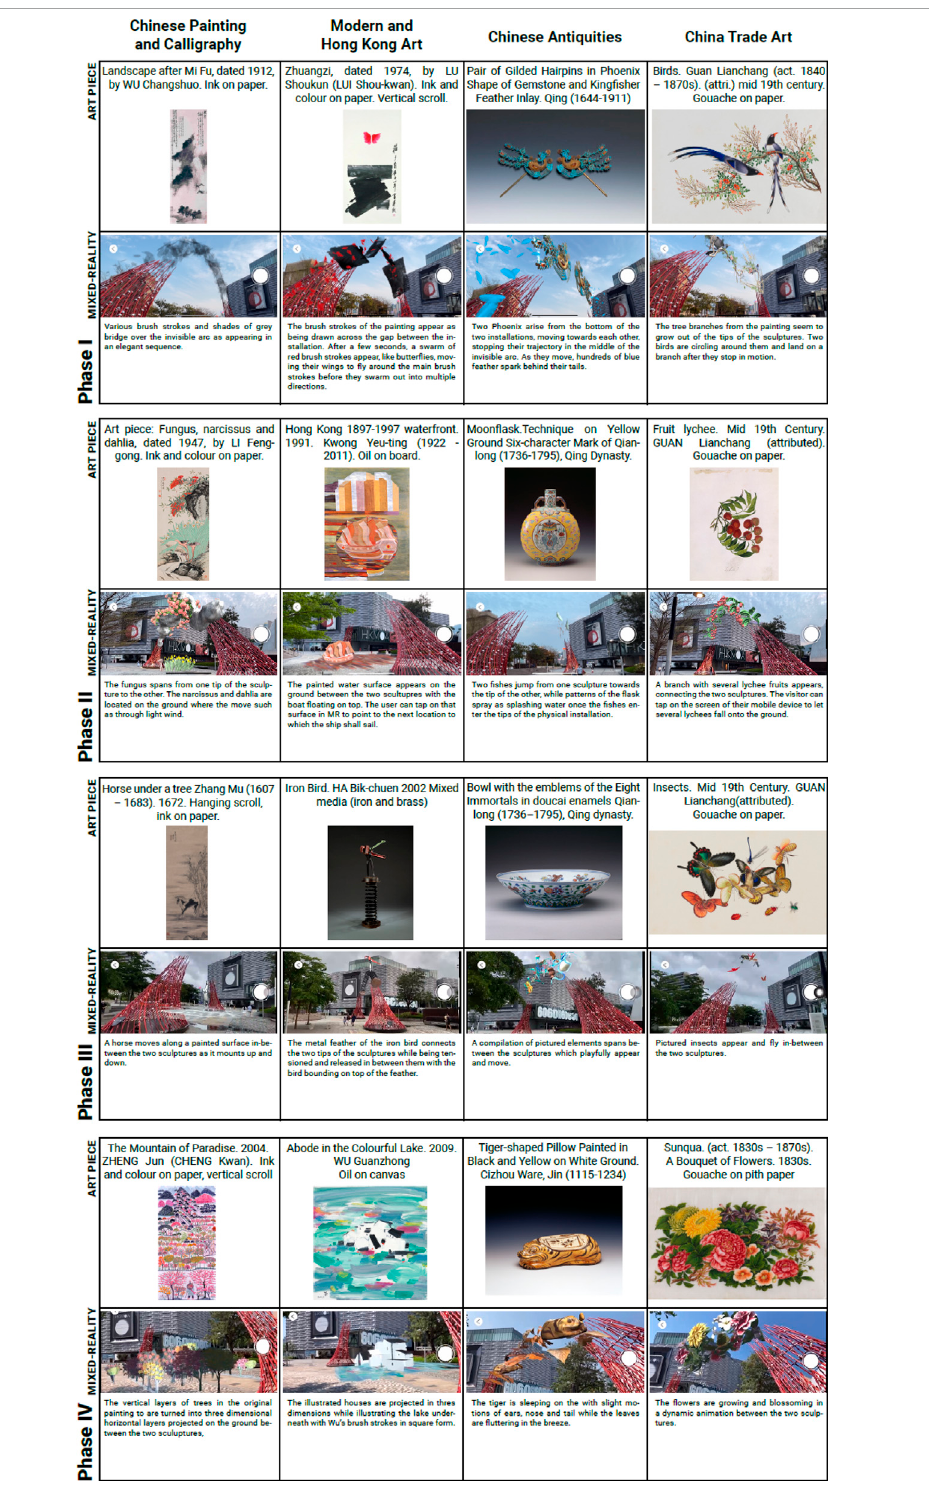
TABLE 1 Assets overview of the four